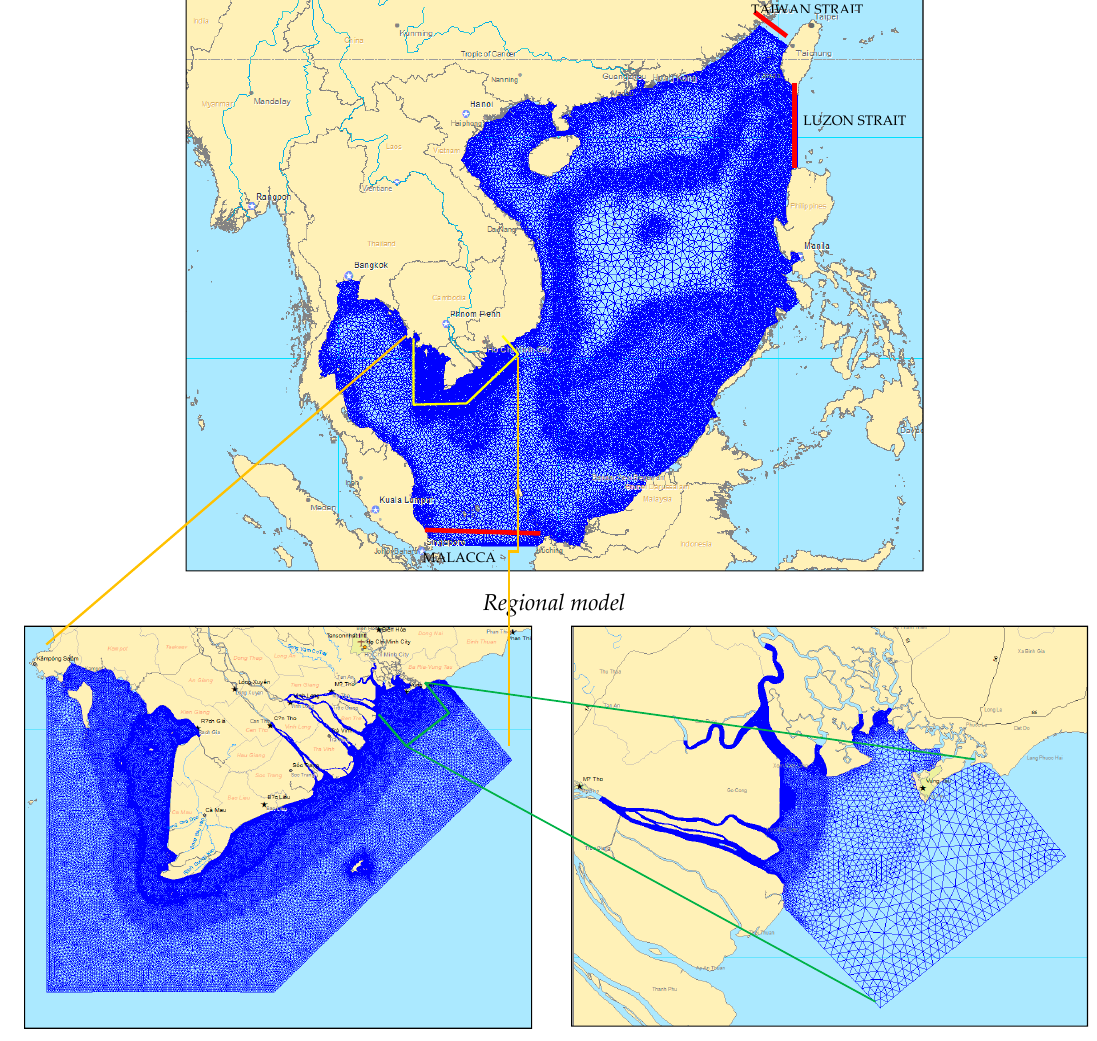
Figure 2. Nesting technique for numerical models.